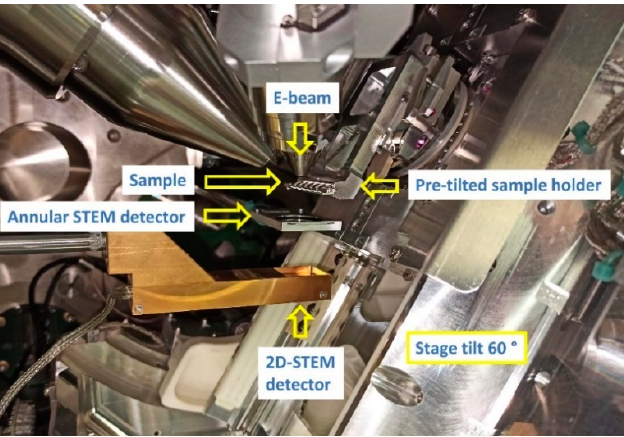
Figure 1. In-chamber situation of the FIB-SEM (Focused ion beam SEM) Helios during 4D-STEM/PNBD data collection: The annular STEM (scanning transmission electron microscopy) detector is used for precise beam alignment and imaging of the 4D dataset sample area. During 4D-STEM dataset acquisition, the annular STEM detector is retracted.